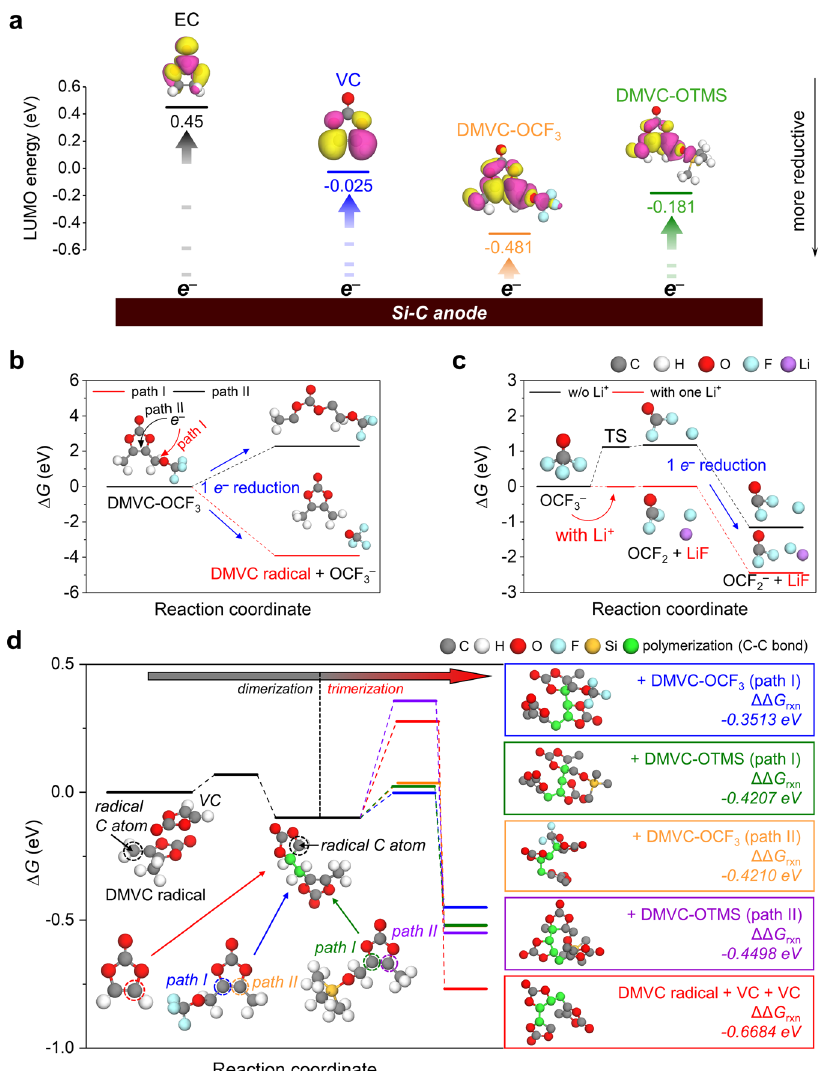
Fig. 3 LUMO energy levels of solvent and additives and Gibbs free energies for the reduction of additives and the polymerization of additives. a LUMO energy levels of EC, VC, DMVC-OCF 3 , and DMVC-OTMS. Note that the isovalue of the orbital is 0.02 e /Å 3 . b – d Reaction paths for the decomposition of DMVC-OCF 3 by one-electron reduction ( b ), decomposition of the OCF 3 anion ( c ), and polymerization by the DMVC radical with VC, DMVC-OCF 3 , and DMVC-OTMS ( d ). Note that the relative Gibbs free energies ( Δ G ) are calculated at 1 atm and 298 K. The ΔΔ G rxn in colored boxes indicates the difference in Δ G s between the product and reactant of trimerization, which represents the heat of reaction in the trimerization reactions of the DMVC radical + VC dimer with VC, DMVC-OCF 3 , or DMVC-OTMS. For the molecular structures in colored boxes, the hydrogen atoms are omitted for